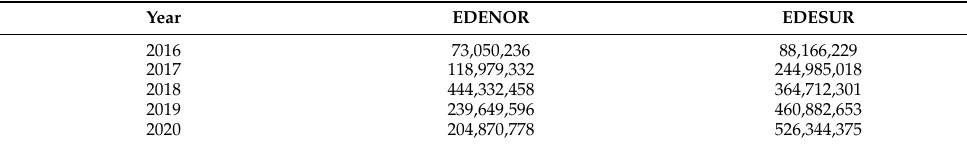
Table 16. Annual compensation expressed in Argentine pesos for EDENOR and